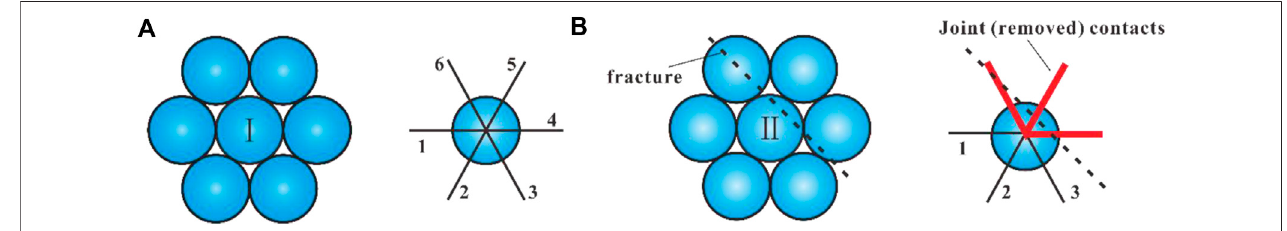
FIGURE5| ContactpatternsfortwodifferenttypesofDEsawayfromandnearthecrack,respectively. (A) NormalcontactsforType Ⅰ . (B) Joint(removed)contacts for Type Ⅱ .